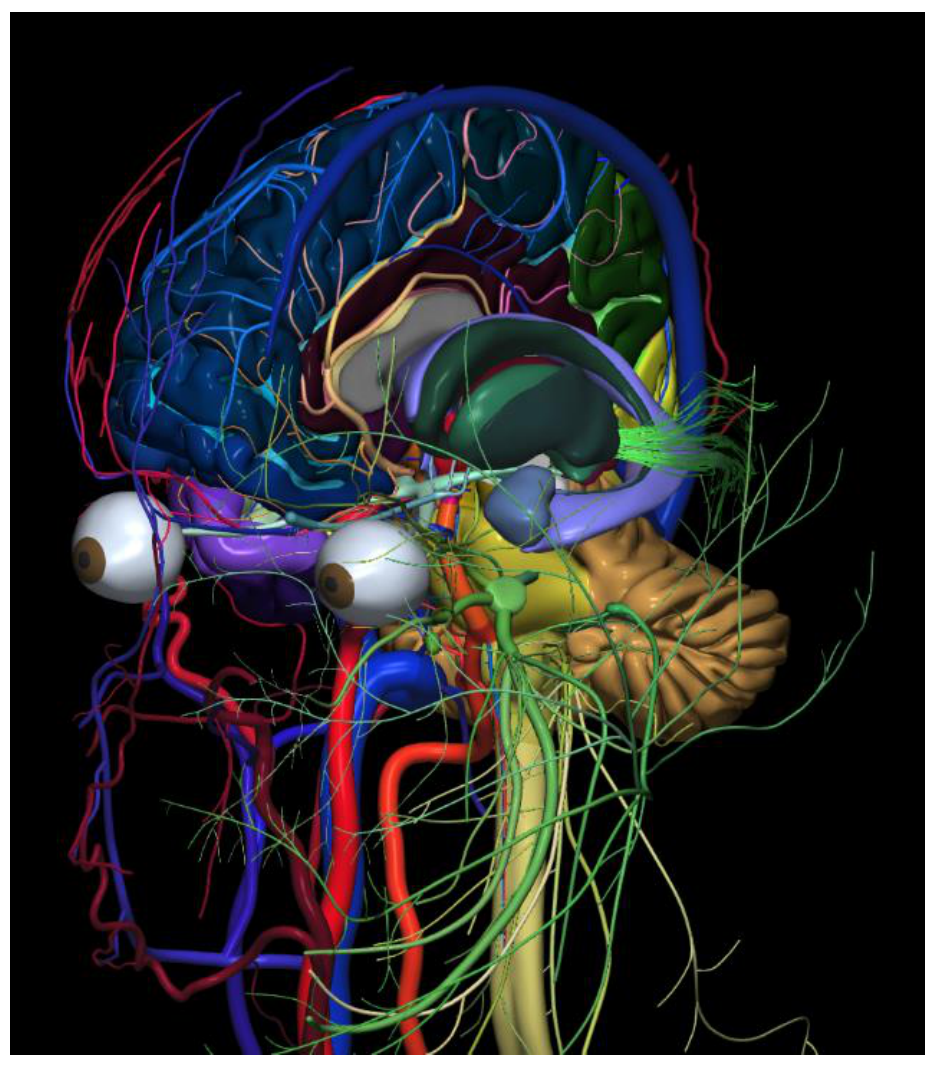
Figure 2. Neuroanatomy composed of 3D pieces (such as Lego blocks) and parcellated by unique color coding. The composed 3D scene contains the brain with the left hemisphere removed and the right hemisphere parcellated into gyri and sulci, cervical spine, deep gray nuclei, cerebral ventricles, intracranial and extracranial vasculature on the right, cranial nerves on the left, and the visual system (an antero-left lateral view).